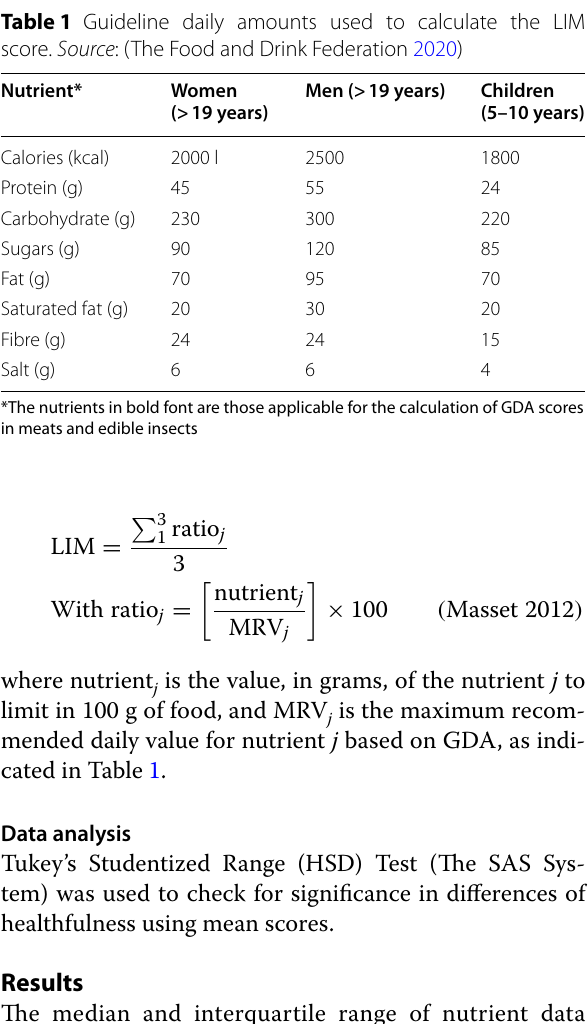
Table 1 Guideline daily amounts used to calculate the